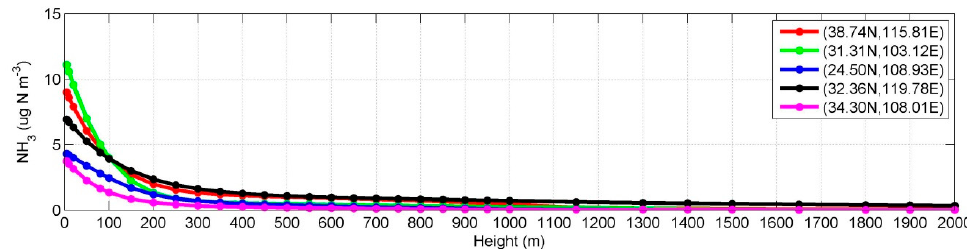
Figure A1. Vertical NH 3 concentrations ( µ g N m − 3 ) simulated by Mozart at five locations in January 2013.